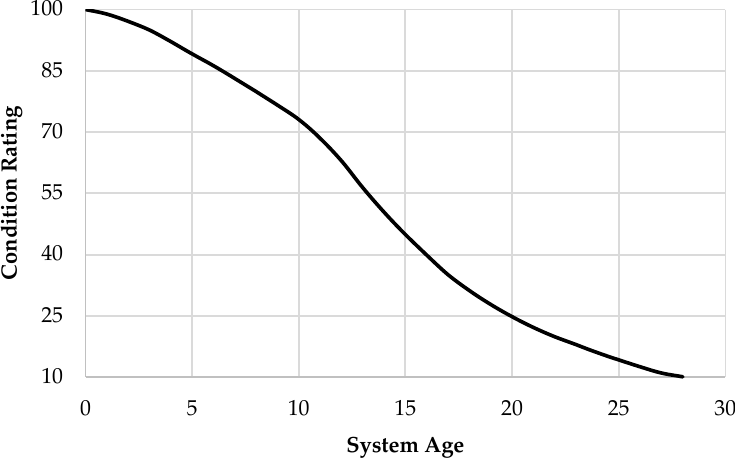
Figure 9. Fuzzy genetic algorithm (GA)-calibrated Markovian deterioration.